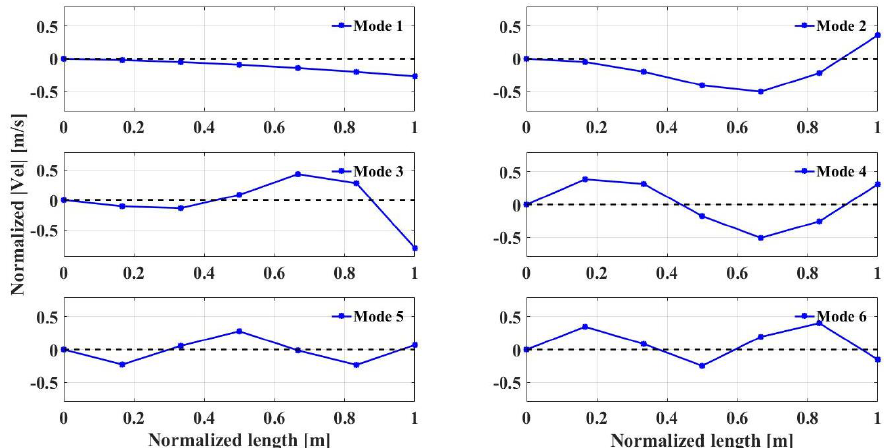
Figure 7. First six bending mode shapes of the